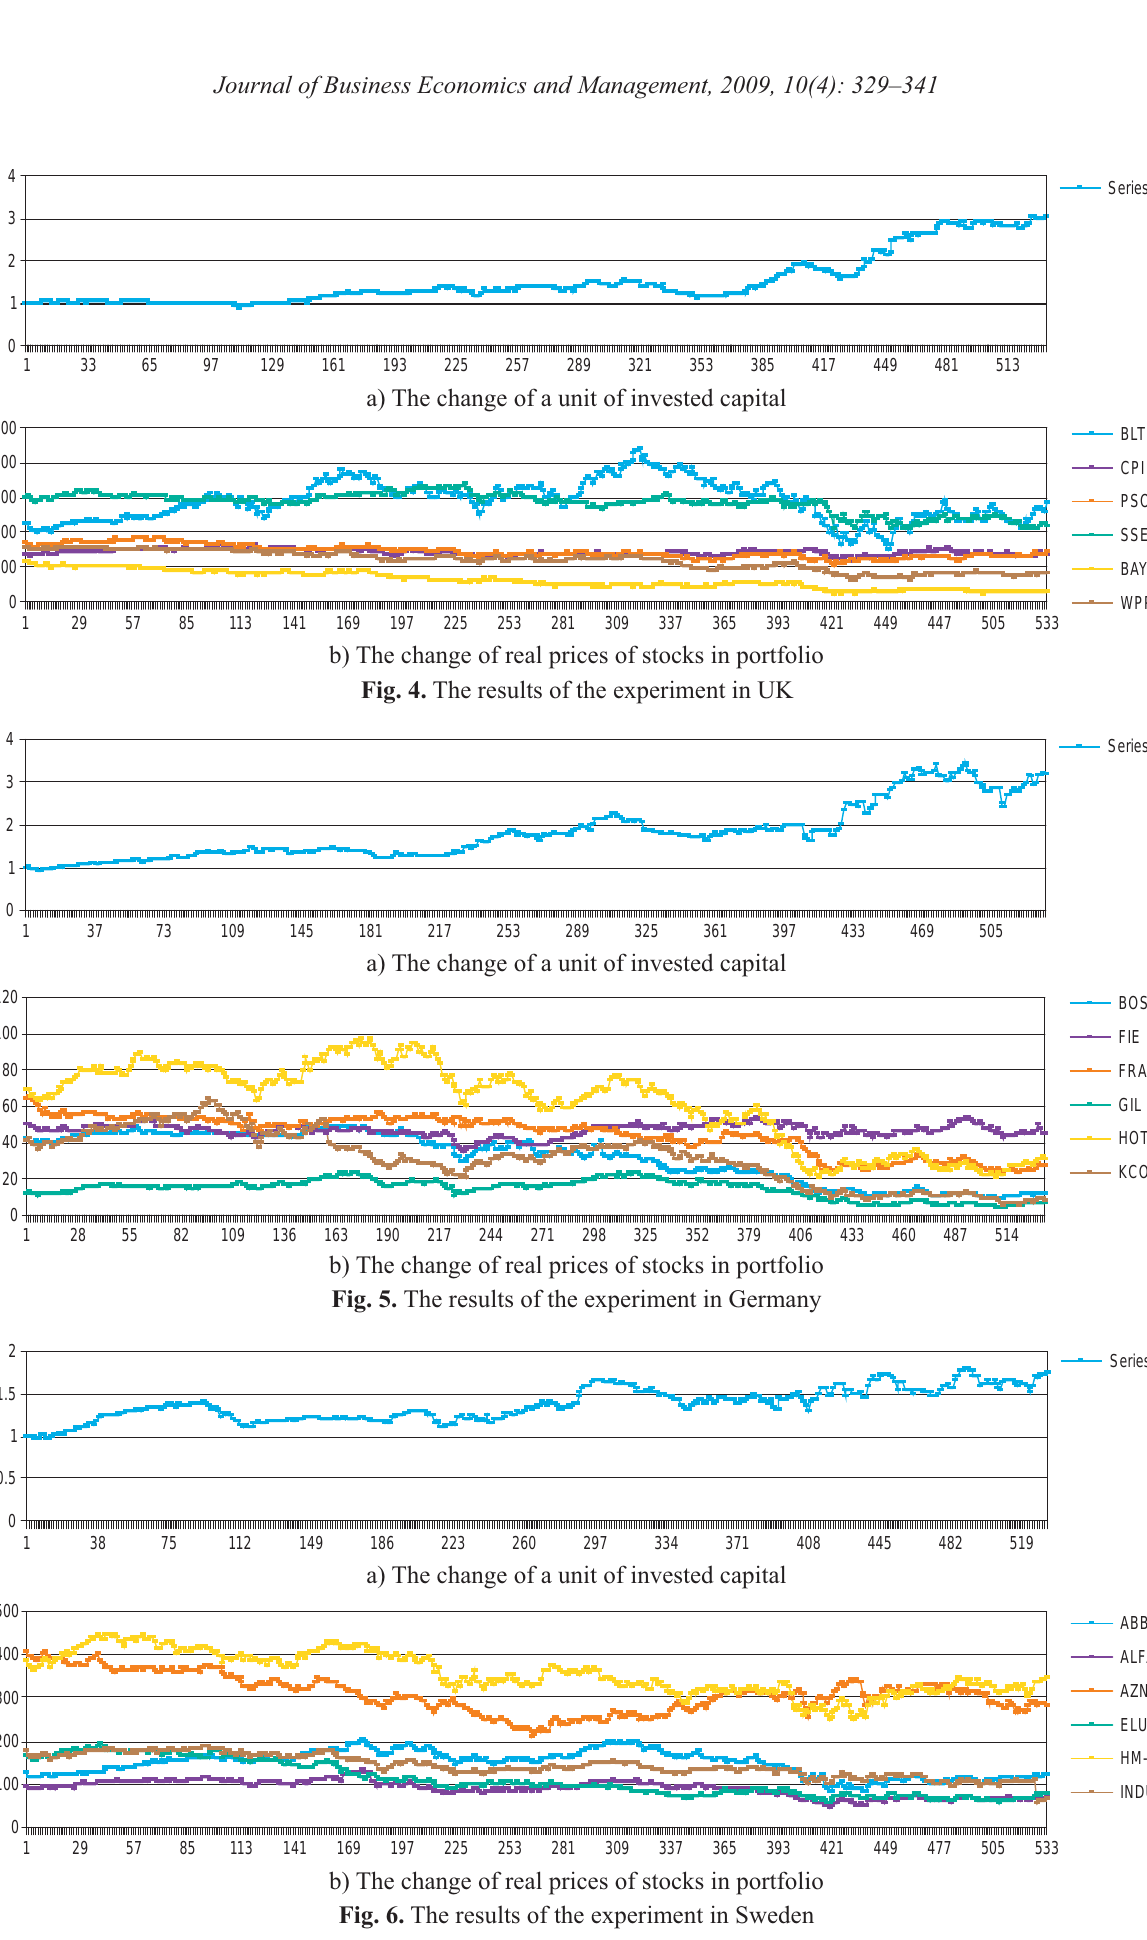
Fig. 6. The results of the experiment in